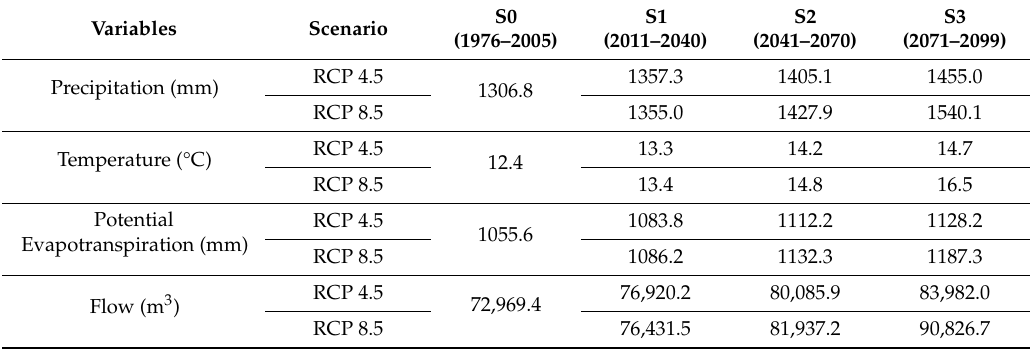
Table 7. The 30-year average annual precipitation, temperature, potential evapotranspiration, and flow during the reference and three future periods for RCP scenarios 4.5 and 8.5 in South Korea. The values in this table were calculated first by converting daily data into annual data and subsequently by calculating the 30-year average annual value of 13 GCMs for each period and the average of 13 GCMs.